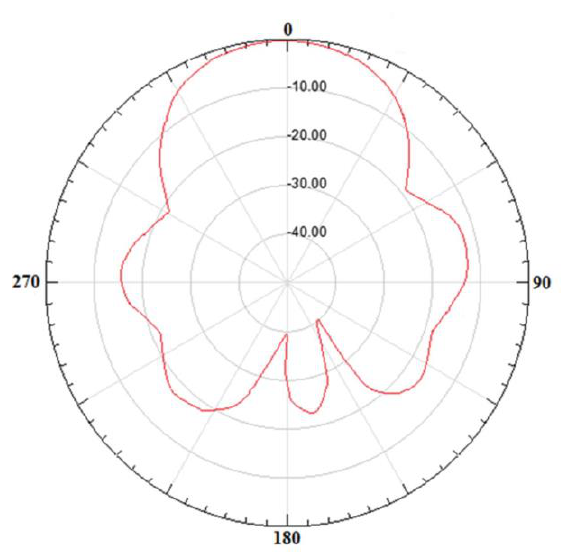
Fig. 9. The antenna pattern in the H